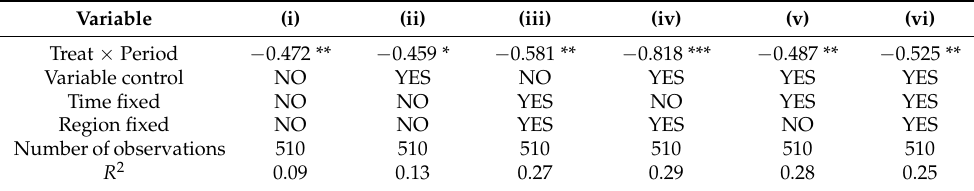
Table 6. DID estimation results of the BLPP effects (industrial wastewater discharge).